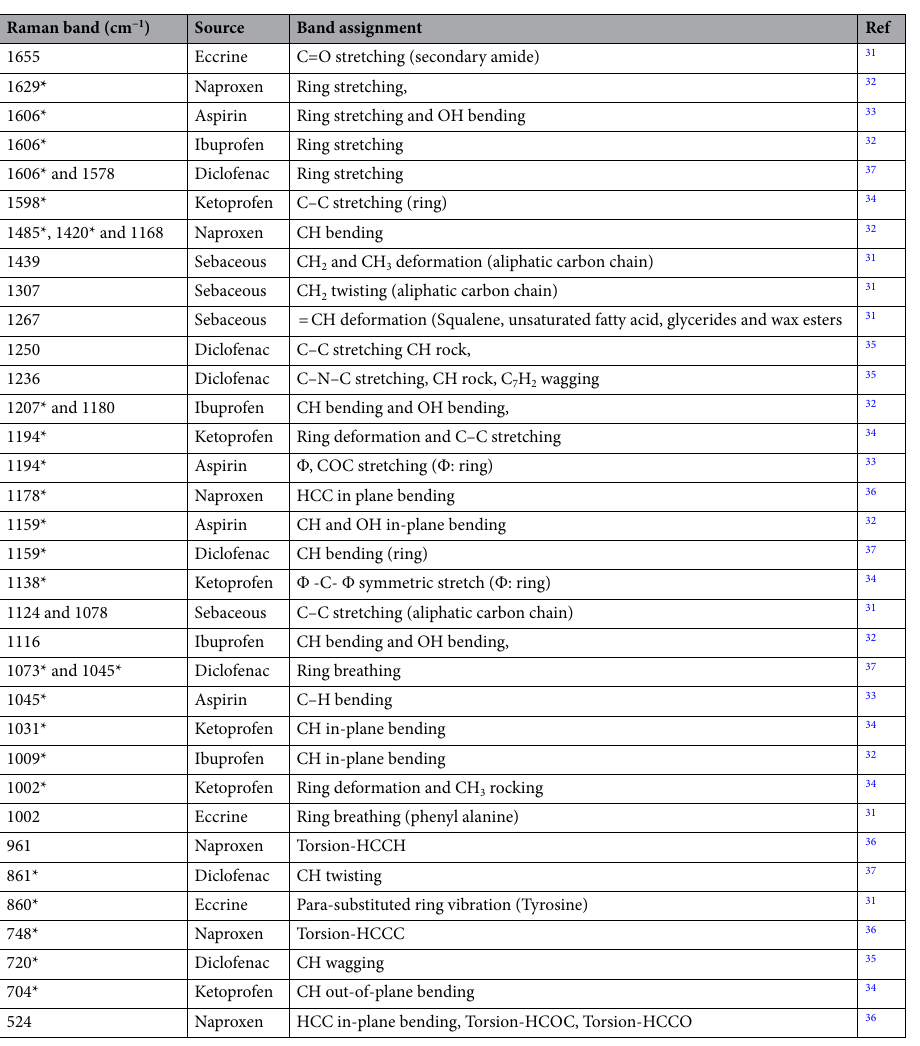
Table 1. Raman band assignment for the natural and NSAID-contaminated fingermarks. The asterisks (*) indicate regions selected using the GA method.